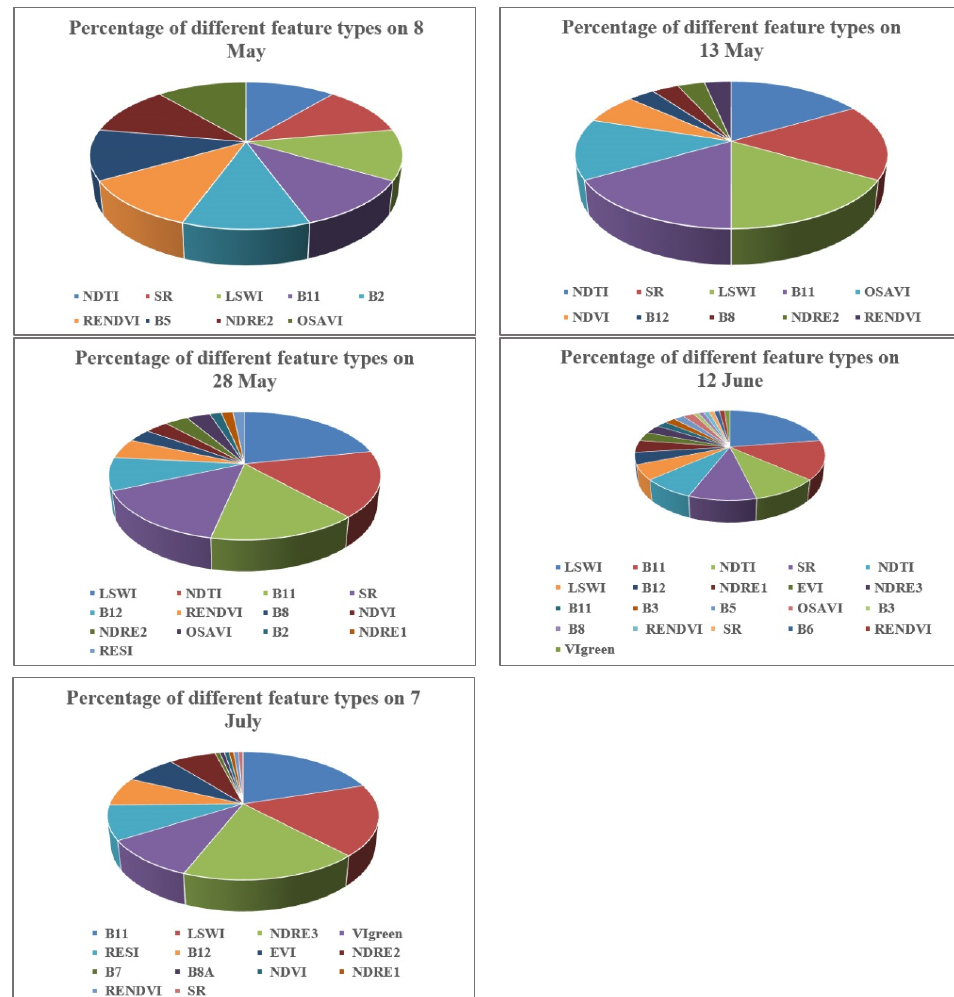
Figure 12. Percentage of different character types of soybeans in 2020 different periods. Table 12. The top-10 optimal feature set of best soybeans combination types for each period in